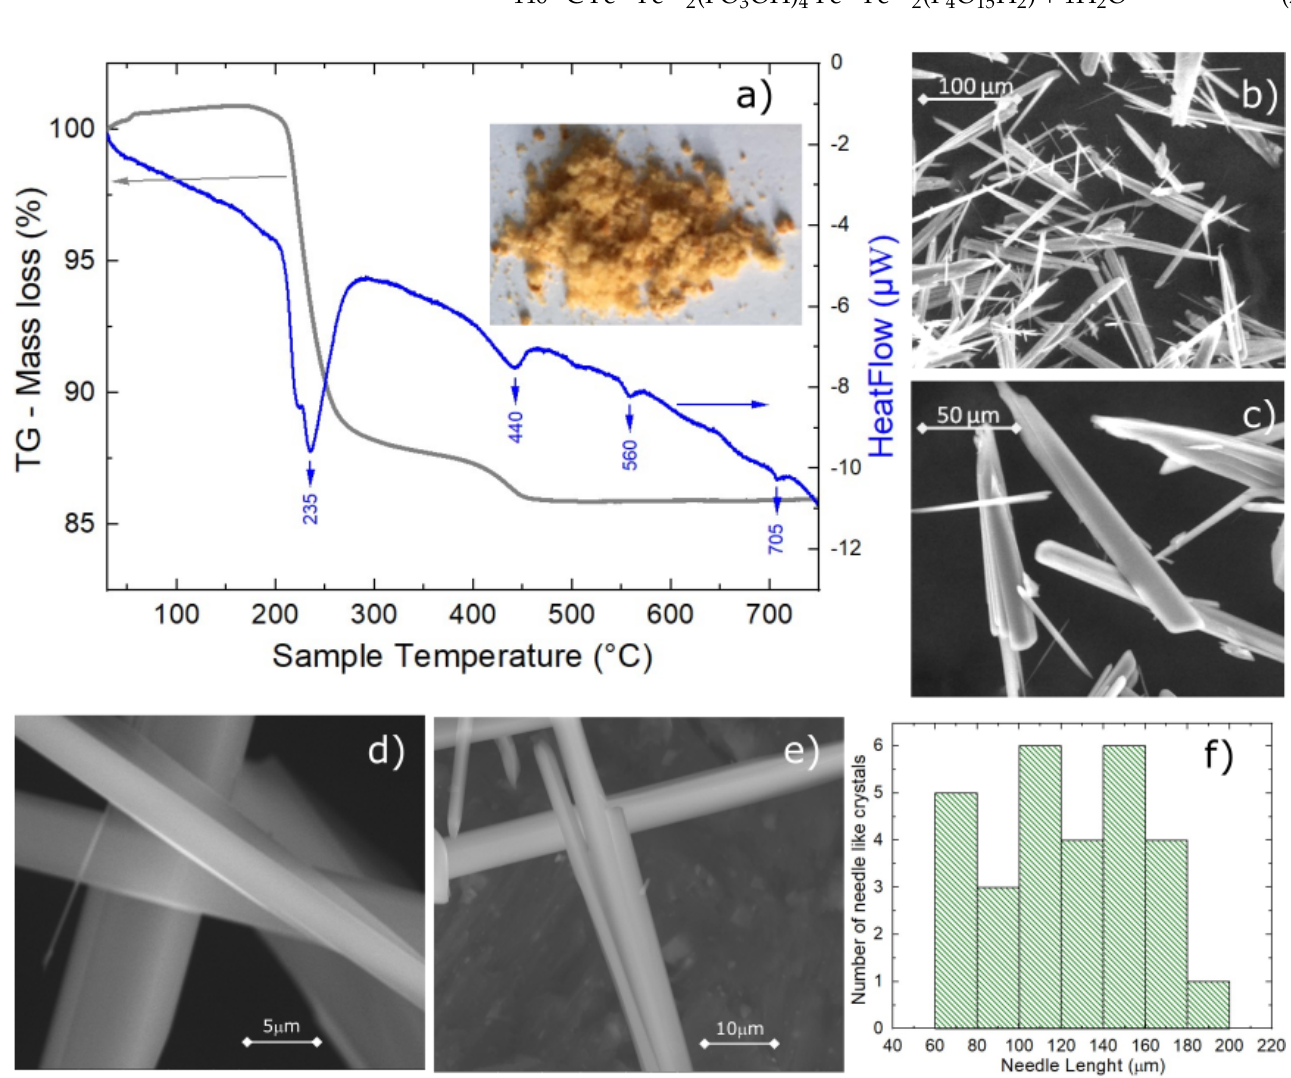
Figure 2. Panel ( a ) TG measurements, indicating the weight evolution, between 30 °C and 750 °C (303 K to 1023 K). The grey line and arrow refer to the TG and the blue line and arrows to the HeatFlow, respectively. The inset photo shows the sample. Panels ( b – e ) SEM image for Fe 2+ Fe 3+2 (PO 3 OH) 4 (H 2 O) 4 sample at different magnifications. Panel ( f ) is the single crystal length distribution chart.